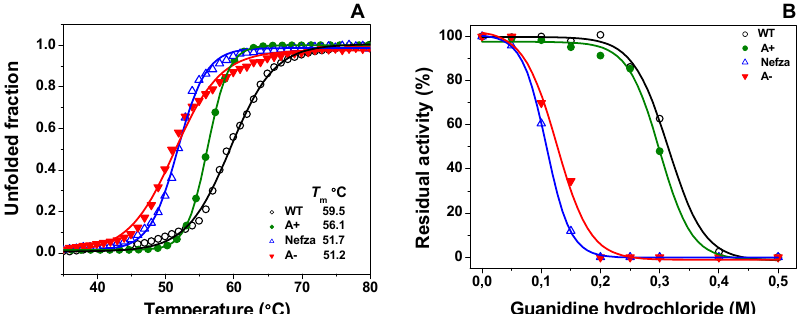
Figure 6. Stability analysis of recombinant human G6PD variants. ( A ) Thermal stability of G6PD variants. Changes in the CD signal at 222 nm were monitored as the temperature increased from 20 ◦ C to 80 ◦ C. The T m (melting temperature midpoint of the transition values) was calculated for each variant. ( B ) Stability analysis of G6PD variants in the presence of guanidine hydrochloride (Gdn-HCl). All enzymes were incubated at 0.2 mg/mL in 50 mM phosphate buffer pH 7.35 in the presence of the indicated concentrations of Gdn-HCl for 2 h at 37 ◦ C and subsequently the enzymatic activity was measured. Residual activity was expressed as a percentage of the activity for the same sample measured at 25 ◦ C without Gdn-HCl and were diluted immediately before use. The experiments were performed in triplicate and the standard errors were less than 4%.